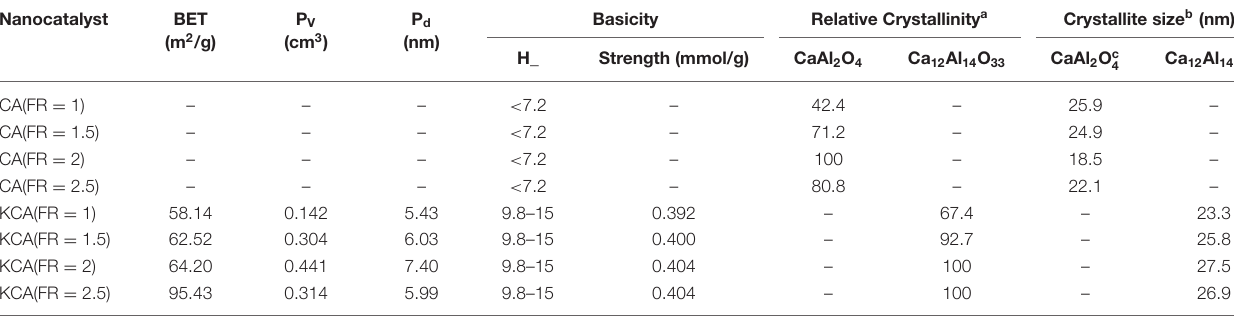
TABLE 1 | Physicochemical properties of synthesized CaAl 2 O 4 supports and KOH/Ca 12 Al 14 O 33 nanostructured catalysts. Nanocatalyst